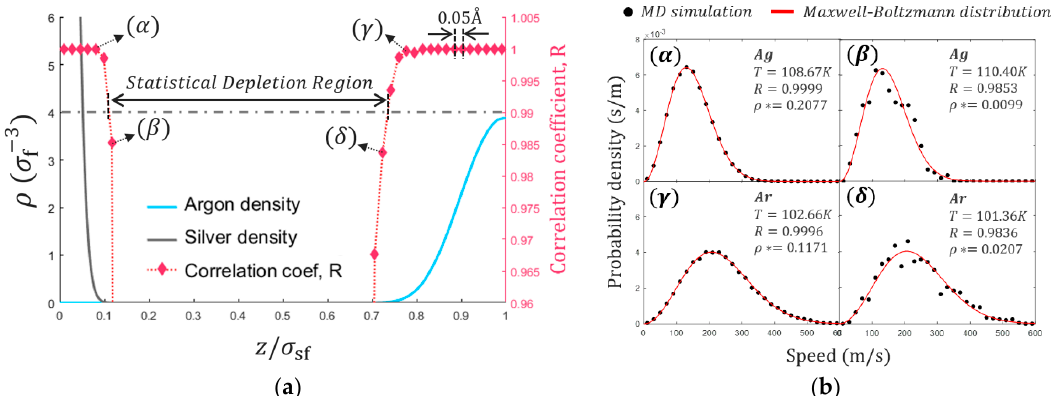
Figure 5. ( a ) The local statistical significance near the solid / fluid boundary with normalized density profiles. ( b ) The normalized distribution of velocity magnitudes and Maxwell-Boltzmann distribution at the corresponding temperature. The location z = 0 is the most probable location of the innermost solid layer.